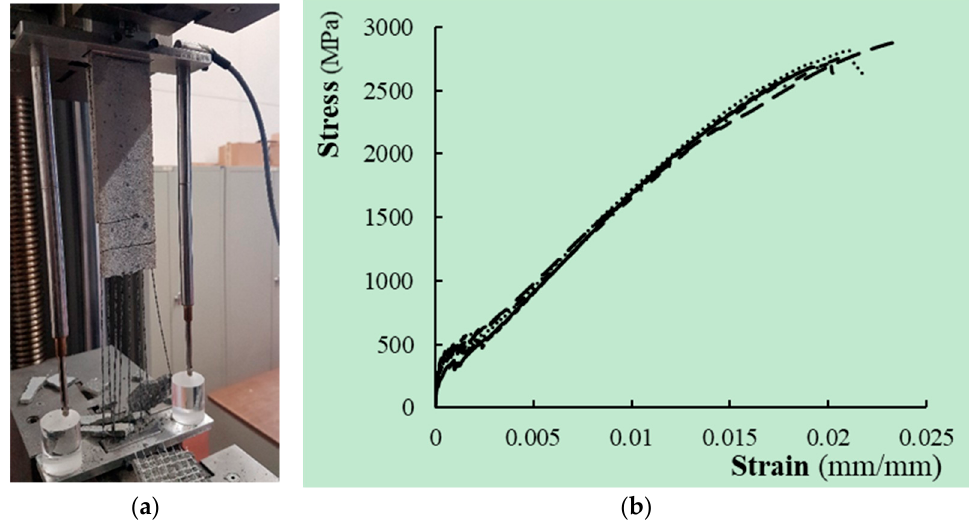
Figure 3. SRG tensile tests: ( a ) Test setup and ( b ) stress–strain curves.